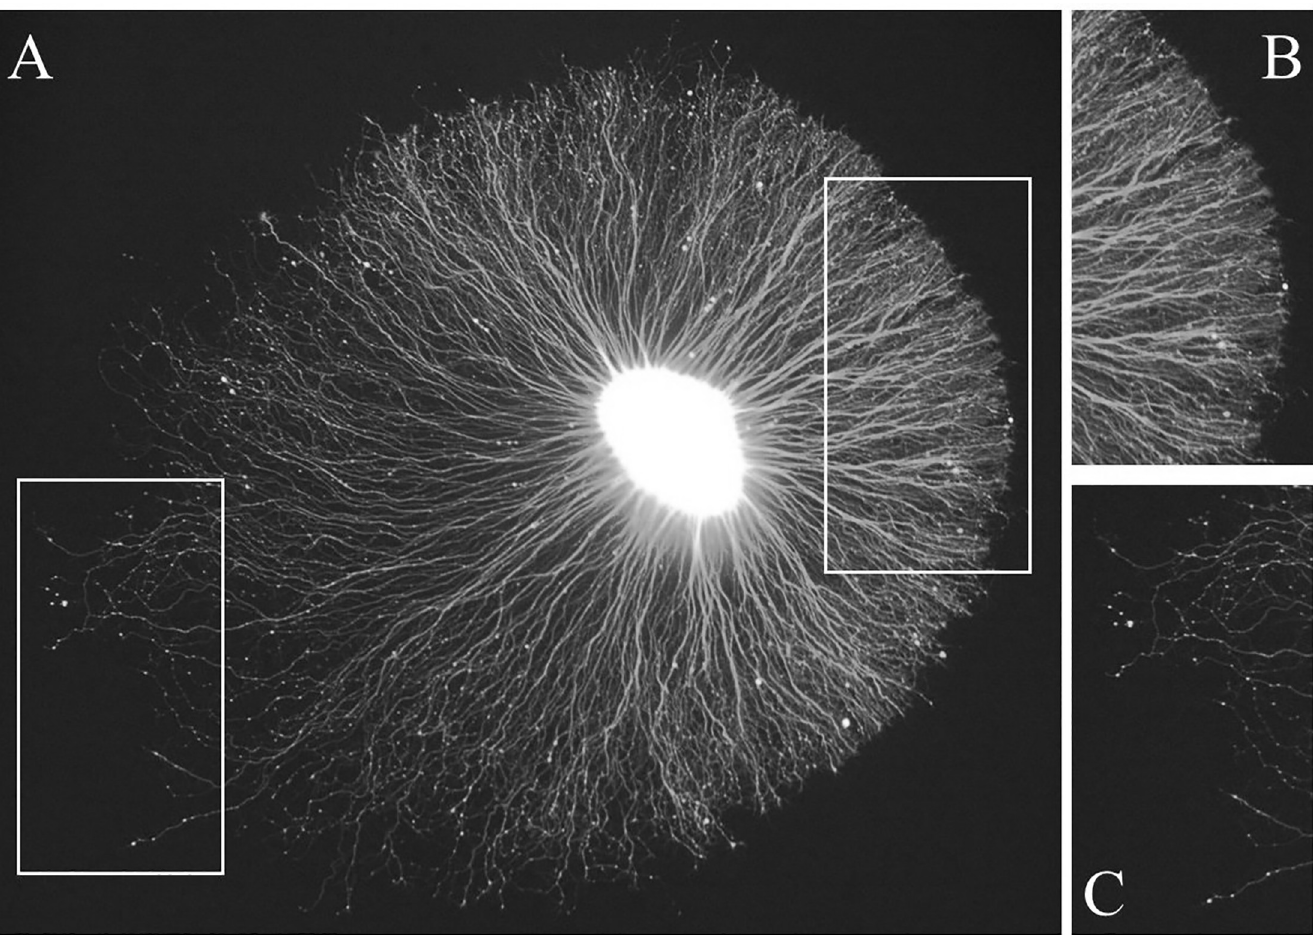
Fig 1. An example of neurite outgrowth from an embryonic chick sympathetic ganglion explant cultured in the presence of Nerve Growth Factor [NGF] stained with vital dye. The tissue has been labeled with a vital dye to reveal the core [bright central area] and surrounding neurites [A]. The neurite halo shows asymmetric outgrowth with the shorter neurites extending to the right side where they form a well-defined edge [inset shown in panel B]. In contrast, the neurites on the left side are thinner and show more variable lengths [inset shown in panel C].